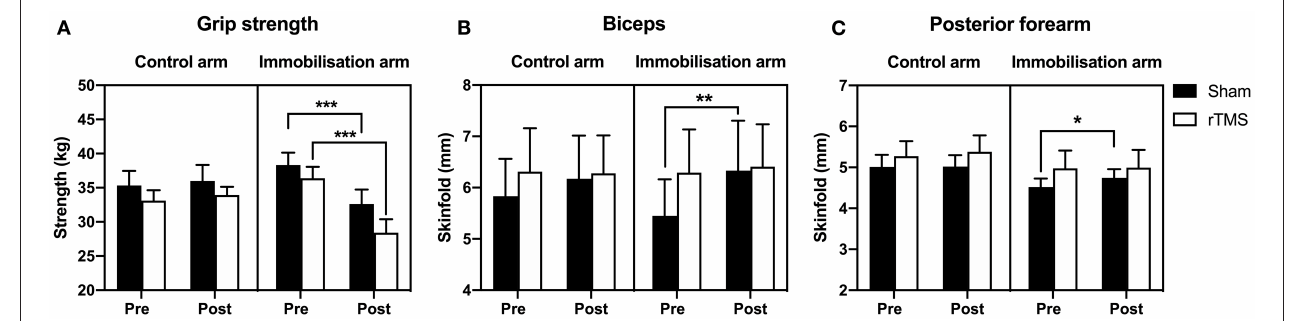
FIGURE 6 | Effect of rTMS on immobilized-induced loss of grip strength and arm composition. (A) Arm immobilization induced a significant decrease in grip strength in both the Sham group (10% loss) and rTMS group (22% loss) ( p < 0.0001). In the Sham group, there was an increase in biceps skinfold ( B ; p < 0.01) and posterior forearm skinfold ( C ; p < 0.05) of the immobilized arm. Such changes in arm composition were not observed in the rTMS group. * p < 0.05; ** p < 0.01; *** p < 0.001.